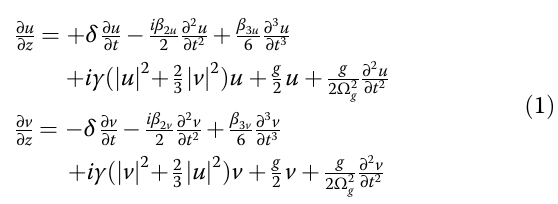
Fig. 8 Schematic illustration of the numerical simulation model. EDF erbium-doped fi ber, SMF single-mode fi ber, DCF dispersion- compensation fi